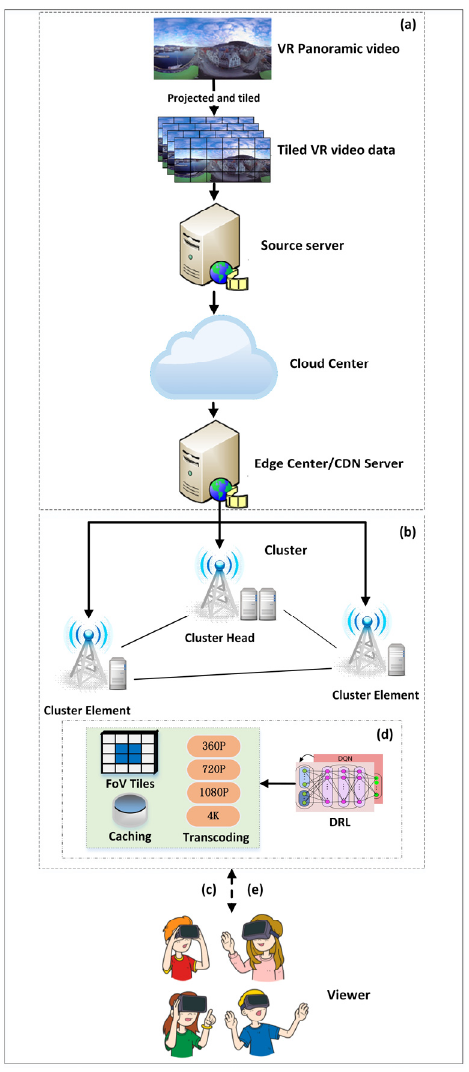
Figure 2. Data perception-driven clustered-edge transmission model for VR panoramic